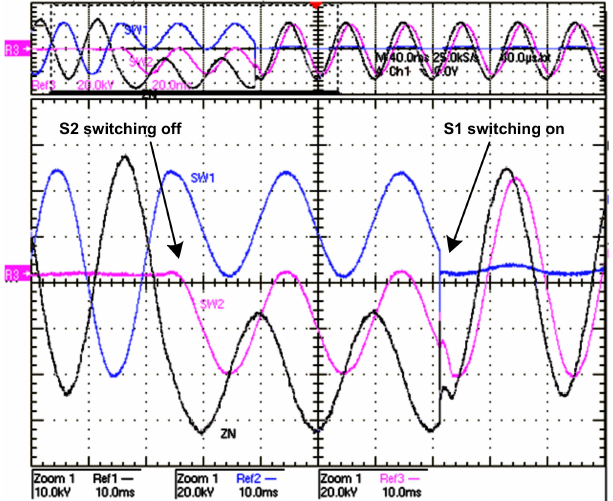
Figure 8. Switching transient between AC static switches S1 and S2 at 30 KV without load obtained